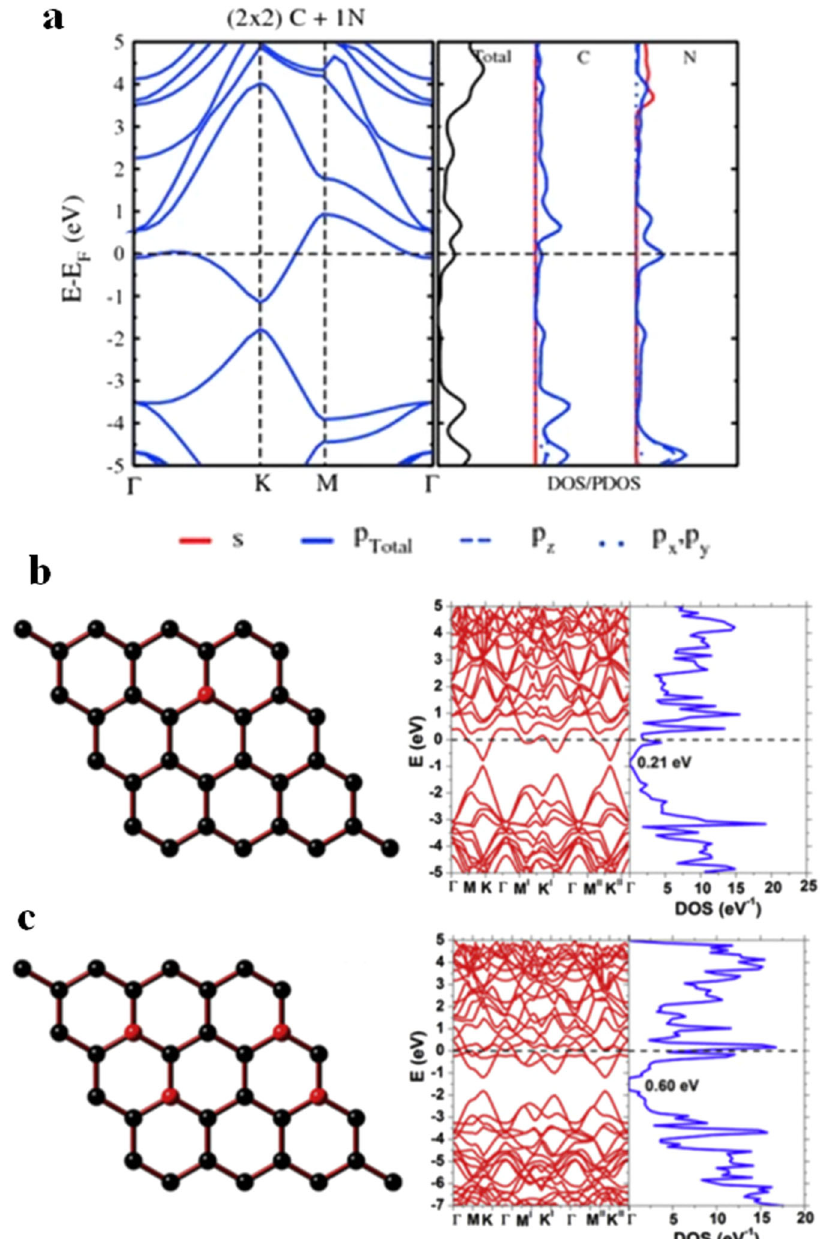
Fig. 9 Density functional theory results. a Energy band structure and density of states of NDG (reproduced from 112 with permission from Springer Nature); b , c optimized structures, energy band structures, and density of states of NDG at different N concentrations (3.13 and 12.50 at.%). Red and black balls represent N and C atoms, respectively (reproduced from 113 with permission from